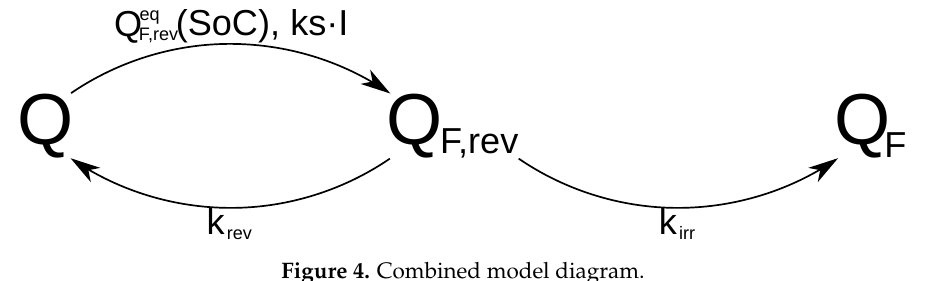
Figure 4. Combined model